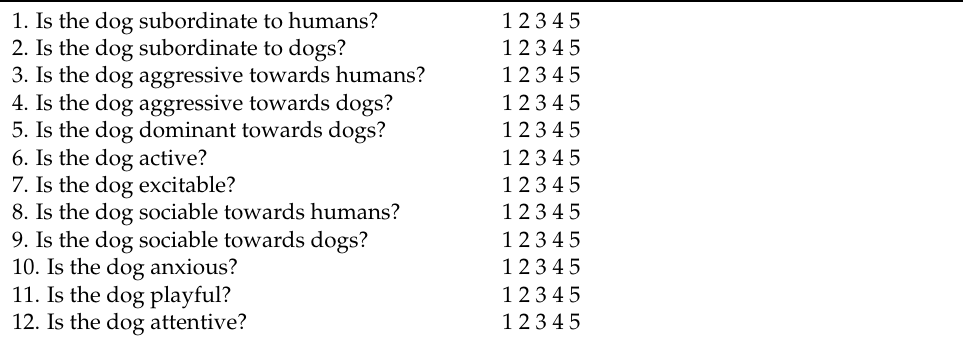
Table A2. The Questionnaire Utilized by the Owners to Describe Dog